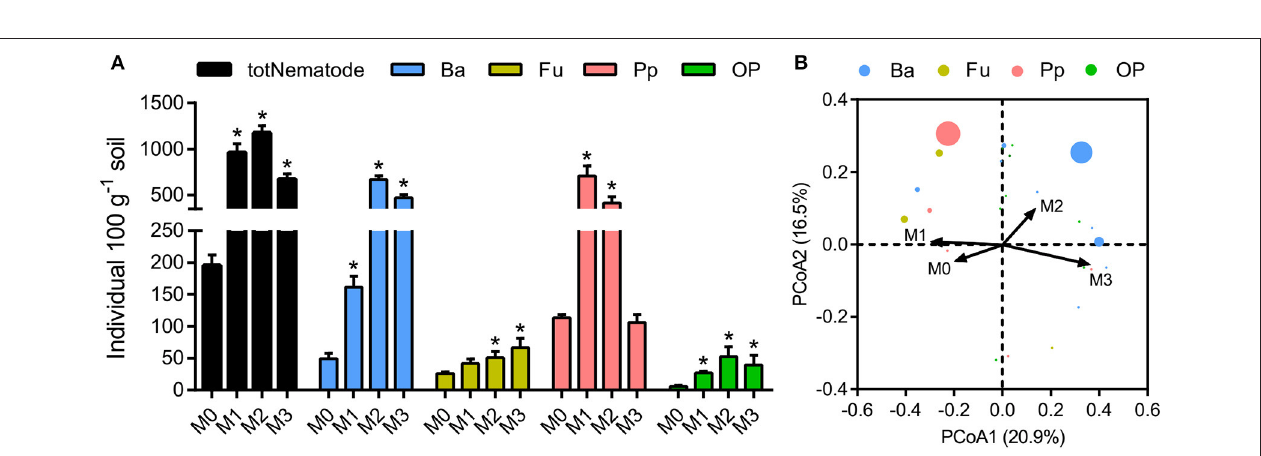
FIGURE 5 | The numbers and structures of nematode assemblages in soil macroaggregates under manure treatments. (A) The numbers of total nematodes (totNematode) and functional groups including bacterivores (Ba), fungivores (Fu), plant parasites (Pp), and omnivores and predators (OP). Bars with * indicate significant differences ( P < 0.05) between manure additions and the M0 treatment, as revealed by one-way ANOVA with Bonferroni’s post-hoc test. (B) The structures of nematode assemblages were well separated by manure treatments based on Bray-Curtis distances using principal coordinate analysis (PCoA). M0, no manure; M1, low manure; M2, high manure; M3, high manure plus